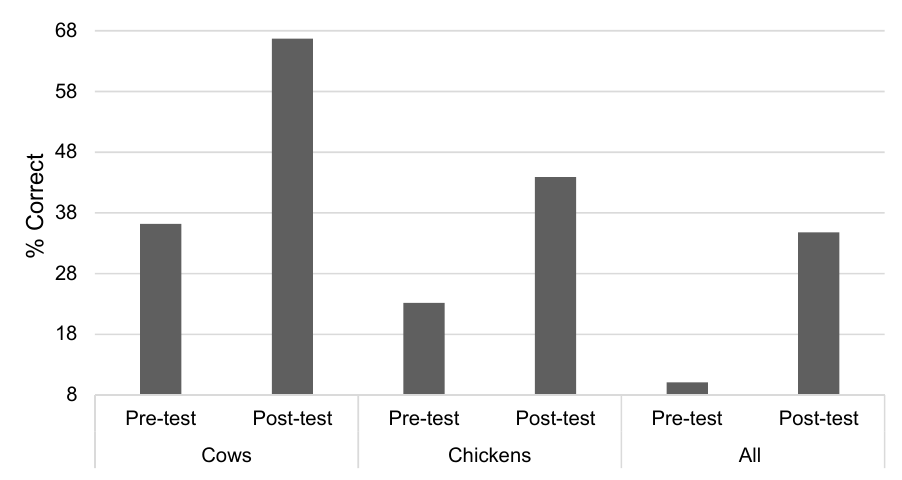
Figure 6. Children’s knowledge about animal welfare in farming systems. Table 8. Descriptive statistics for knowledge about animal welfare in photos of farming systems.